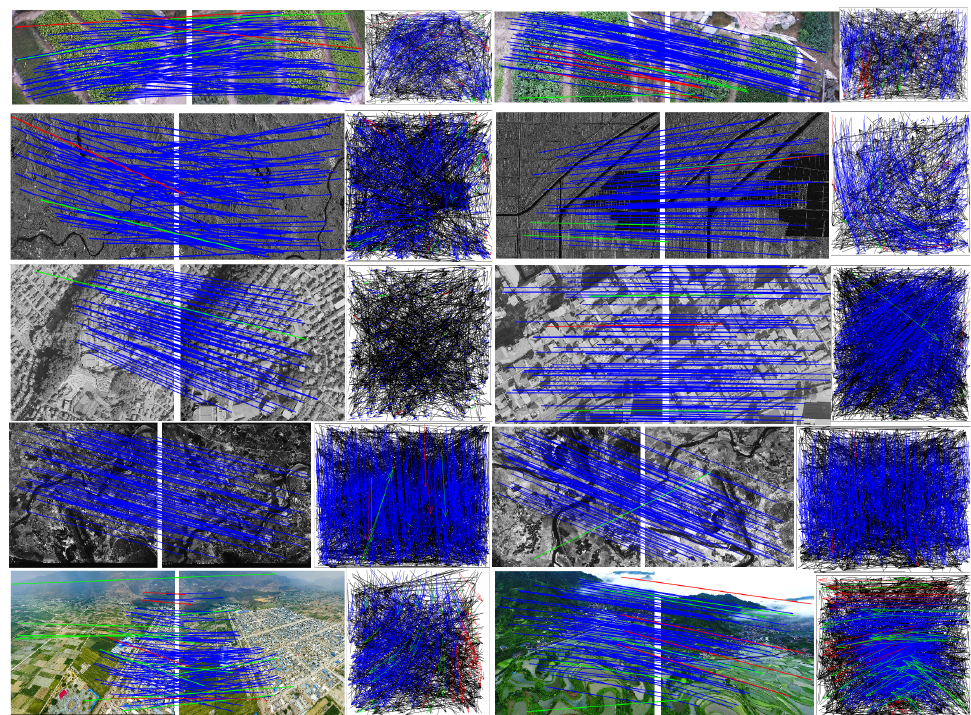
Figure 6. Feature-matching results of our LAF on 10 representative remote-sensing image pairs. (( top ) to ( bottom ) and ( left ) to ( right )) UAV1, UAV2, SAR1, SAR2, PAN1, PAN2, CIAP1, CIAP2, FE1, and FE2 (blue = true positive, black = true negative, green = false negative, and red = false positive). For each example, the graph on the left represents the intuitive result for the image pair, and the graph on the right represents the corresponding motion field.